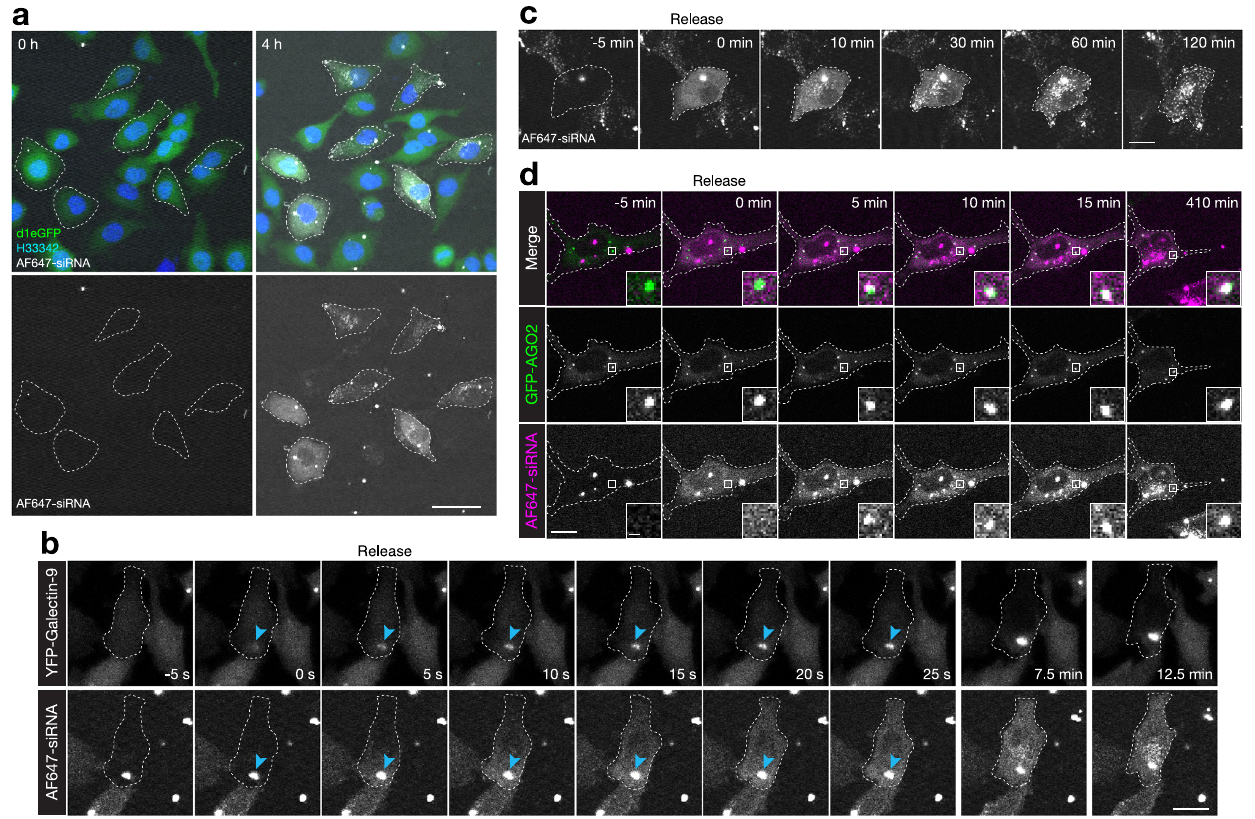
Fig. 1 | Detecting cytosolic delivery of siRNA during sub-nanomolar siRNA transfection. Airyscan confocal imaging of HeLa cells during treatment with lipoplexed AF647-siRNA. a HeLa cells stably expressing d1-eGFP exhibiting the cytosolic distribution of AF647-siRNA after 4h siRNA treatment. The scale bar is 50 µ m. Representative images of eight independent experiments. b HeLa cells expressing YFP-galectin-9 were imaged every 5s during siRNA transfection, to visualize de novo galectin-9 recruitment to lipoplex-containing vesicles, followed by endosomal release and gradual cytosolic dispersion of AF647-siRNA. Outlines indicate cell boundaries and arrows indicate the releasing particle. The scale bar is